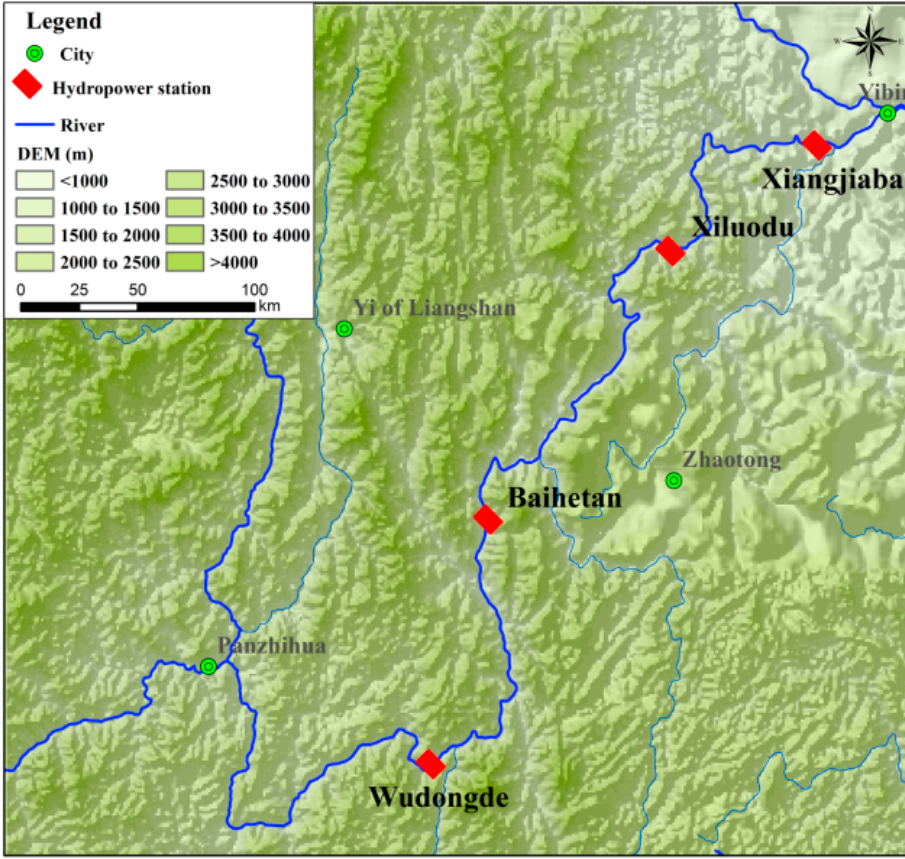
Figure 12. Locations of major cities and hydrological stations along the Jinsha River. Table 1. Main parameters of the four cascade hydropower stations along the lower reaches of the Jinsha River.